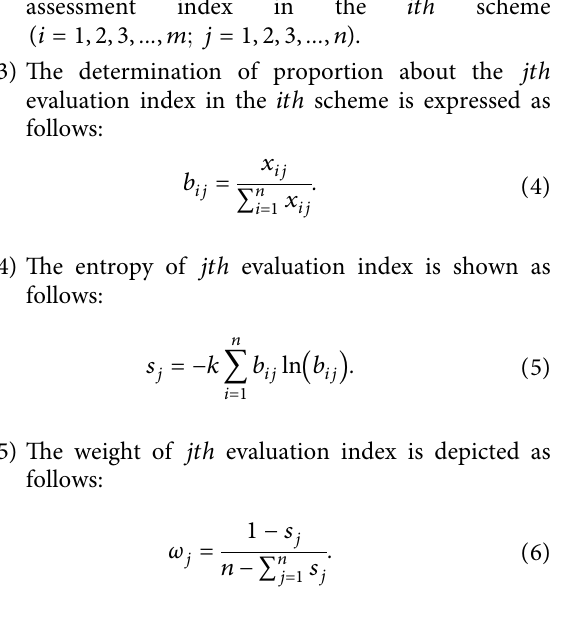
Figure 2: The zoning map of landforms.